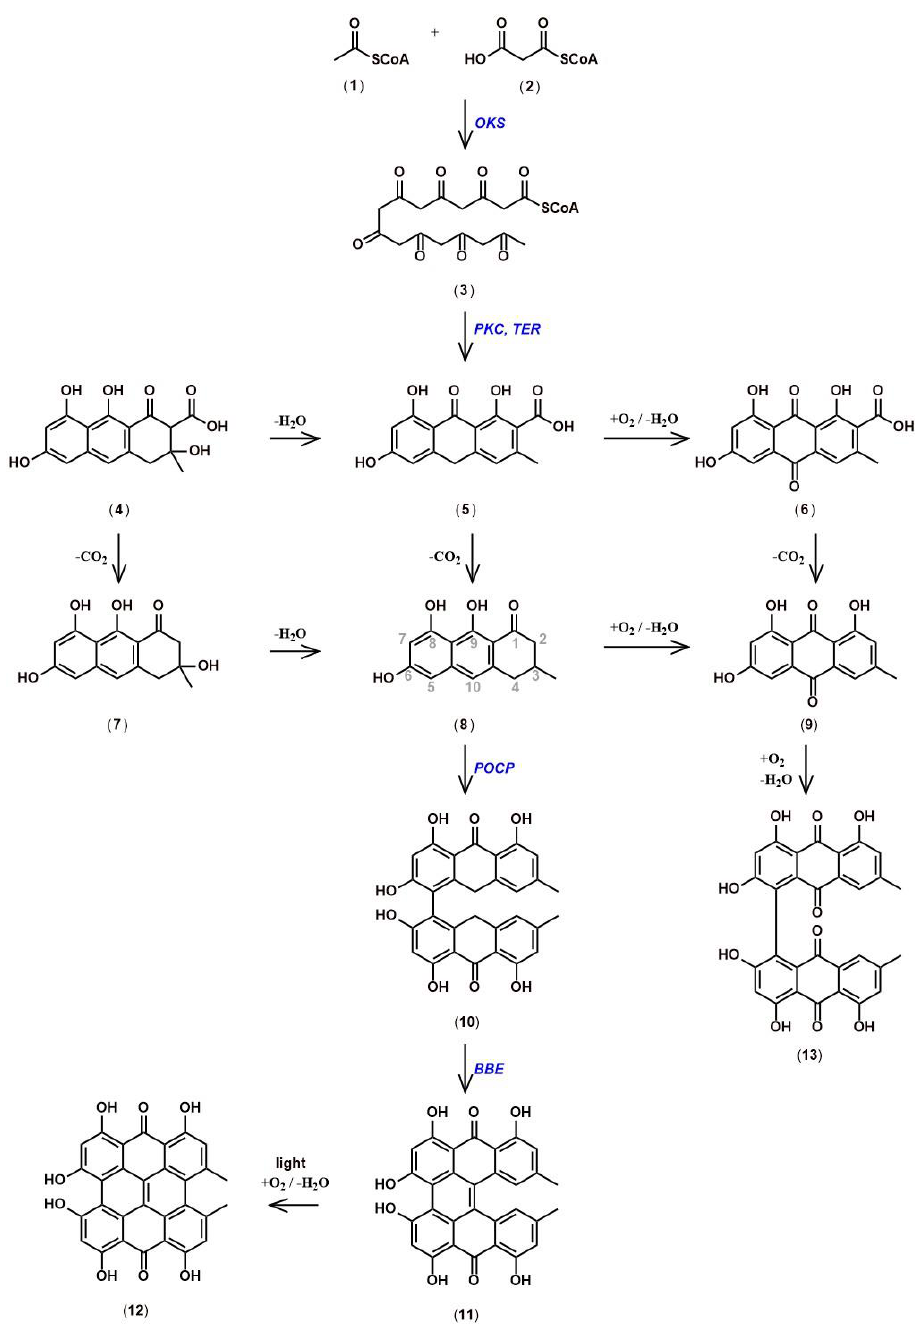
Figure 6. The hypothetical pathway for the biosynthesis of hypericin: Enzymes, represented in blue are suggested by previous literature.: OKS , octaketide synthase; PKC , polyketide cyclase; TER , thioesterase; POCP , phenoloxidative coupling protein; BBE, berberine bridge enzyme.